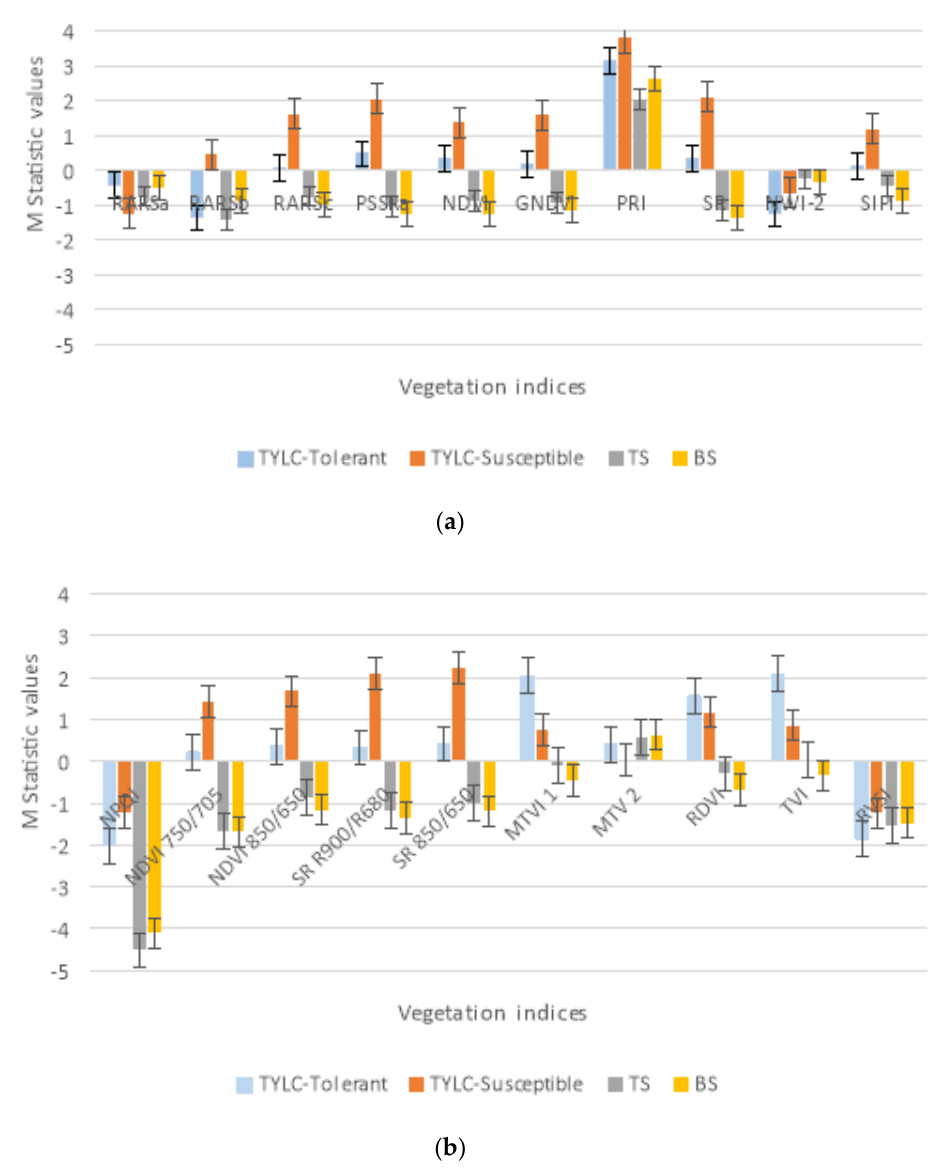
Figure 6. The M statistic value of vegetation indices (VIs) for TYLC, BS, and TS diseases in the field (UAV-based): ( a ) first group of VIs, and ( b ) second group of VIs. The vertical lines present error bars.